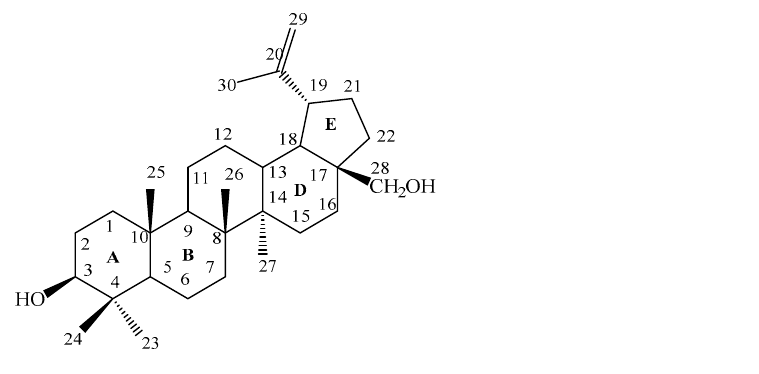
Figure 1. Betulin (3 β ,28 ‐ dihydroxy ‐ 20(29) ‐ lupen or lup ‐ 20(29) ‐ en ‐ 3 β ,28 ‐ diol).